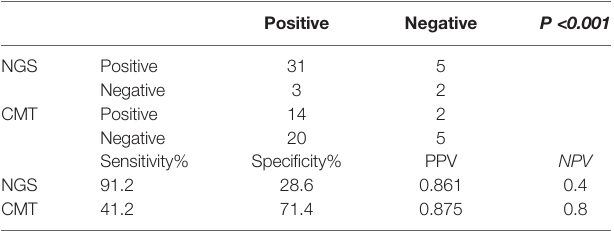
TABLE 2 | Comparison of positive results among next-generation sequencing and conventional microbiological